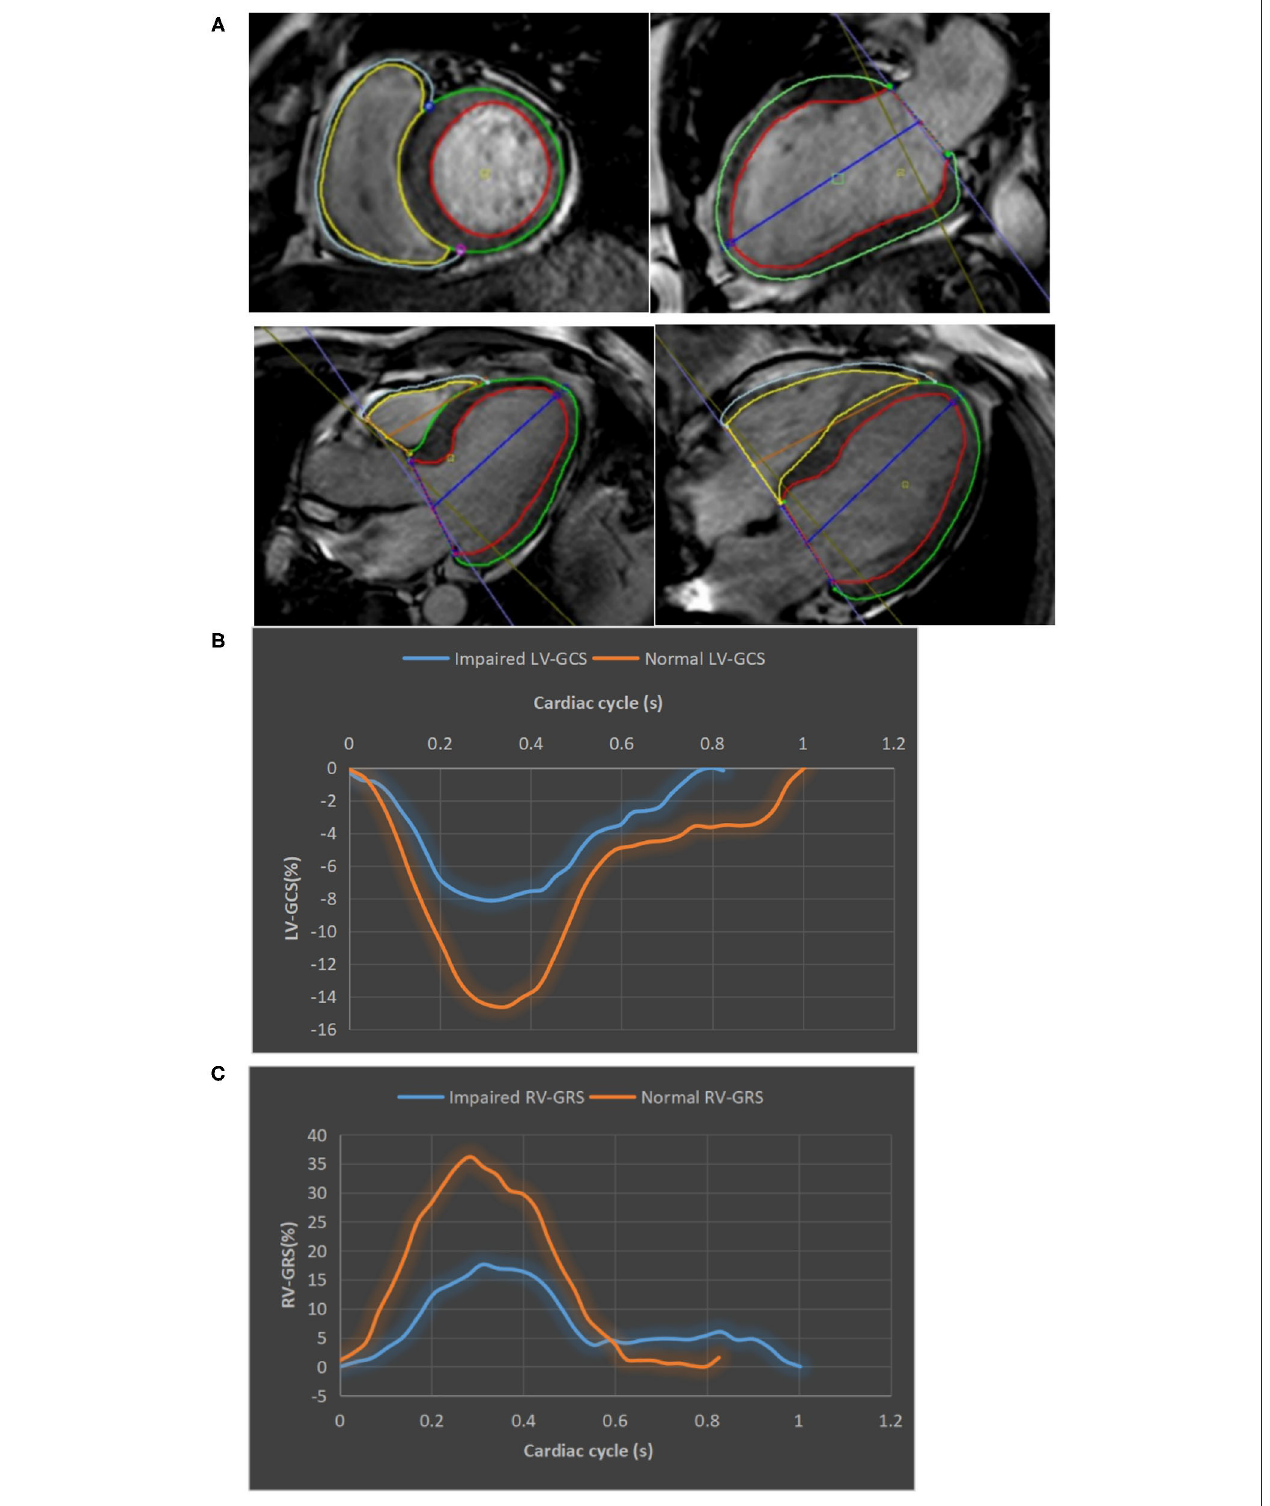
FIGURE 2 | The measurement of LV/RV strains. (A) LV and RV tracking in cine CMR short axis, two-, three-, and four-chamber views. The epicardial and endocardial contour of LV/RV were delineated by green, red, gray, and yellow lines, respectively. (B) Strain curves of a patient with impaired LV-GCS ( − 8.13%) and a patient with normal LV-GCS ( − 14.62%). (C) Strain curves of a patient with impaired RV-GRS (17.61%) and a patient with normal RV-GRS (36.15%). CMR, cardiac magnetic resonance; GCS, global circumferential strain; GRS, global radial strain.